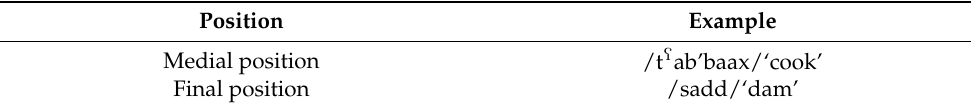
Table 1. Examples of geminates in medial and final positions in